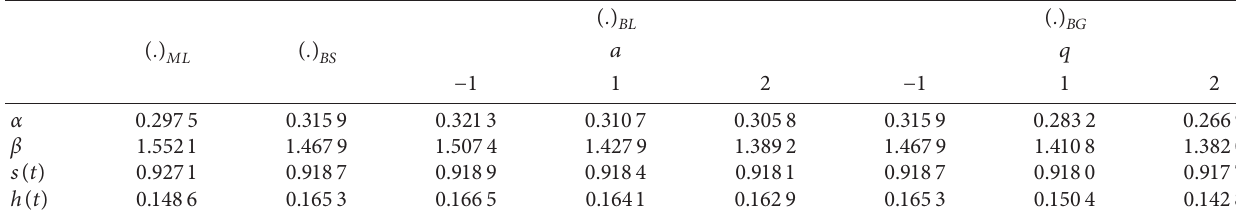
Table 3: The MLEs and BEs of α , β , s ( t ) , and h ( t ) where s ( 0 . 450 ) � 0 . 9243 and h ( 0 . 450 ) � 0 . 1538.